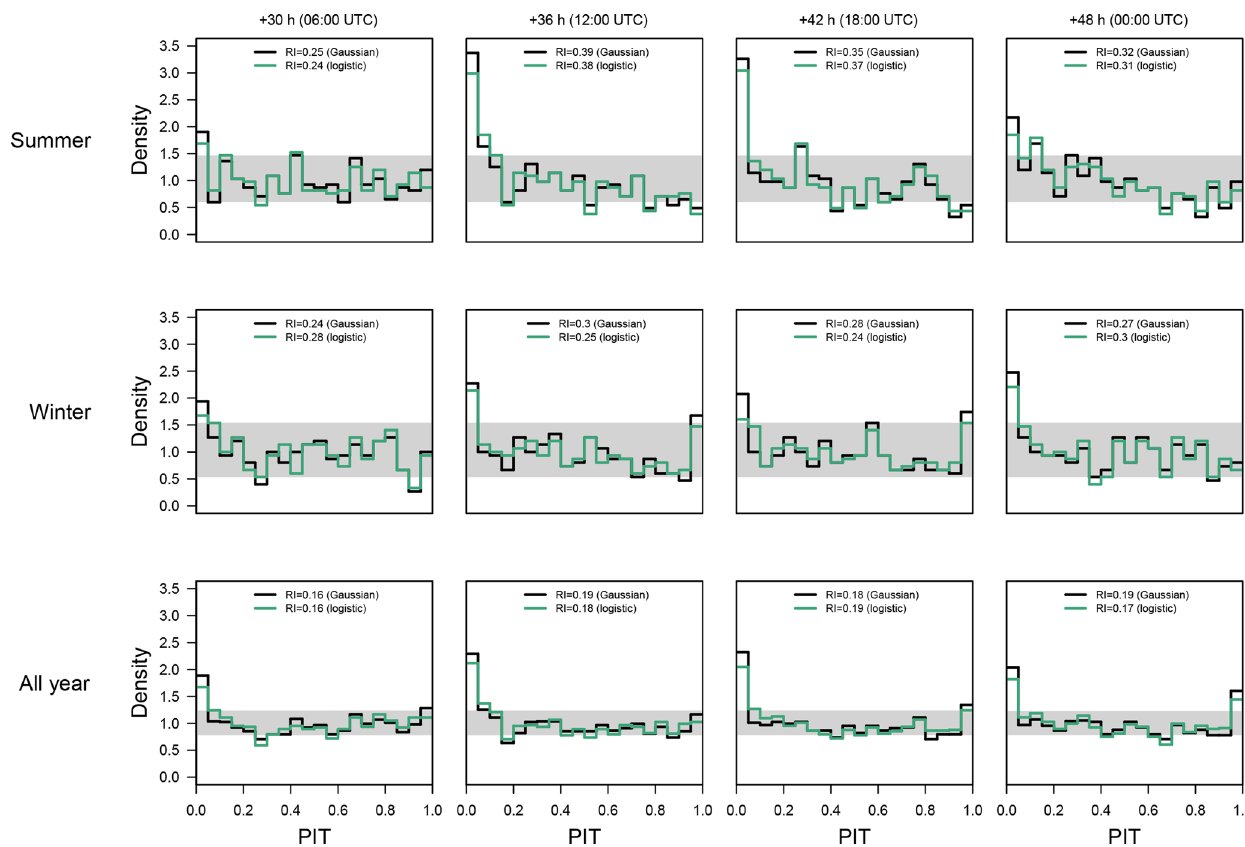
Figure 10. PIT histograms at the Alpine site for the Gaussian (black/dark line) and logistic (green/bright line) sliding 60d models us- ing CRPS optimization for the 2d ahead forecasts (left to right: 06:00, 12:00, 18:00, and 00:00UTC) corresponding to forecasts + 30, + 36, + 42, and + 48h ahead. From the top down, the PIT histograms are shown for summer only (June/July/August), winter only (De- cember/January/February), and for the whole year. The gray horizontal bar shows the point-wise 95% confidence interval around 1 which indicates perfect